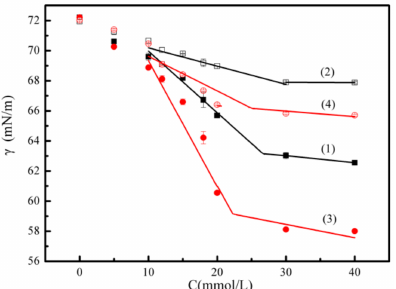
Figure 3. Surface tension as a function of the concentration of xanthates solution at 298 K (butyl xanthate (cid:4) ; isobutyl xanthate ; initial (1), (3); equilibrium (2), (4)).